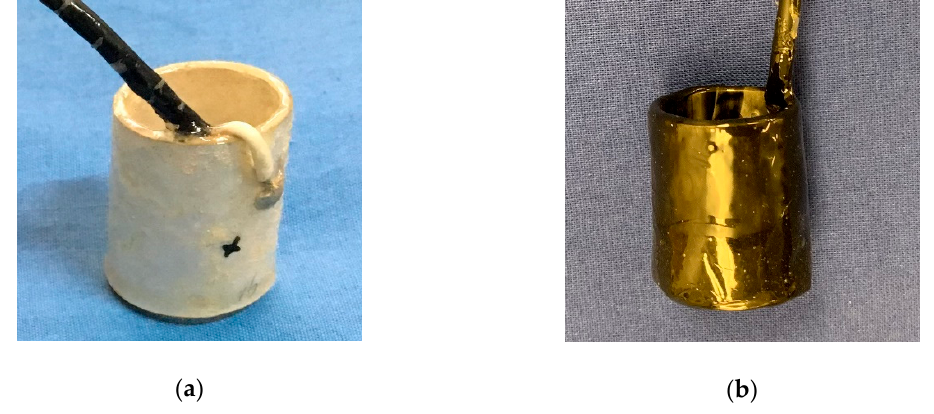
Figure 2. Electrical insulation and waterproofing process: ( a ) epoxy resin protective coating and ( b ) liquid electrical tape protective layer.